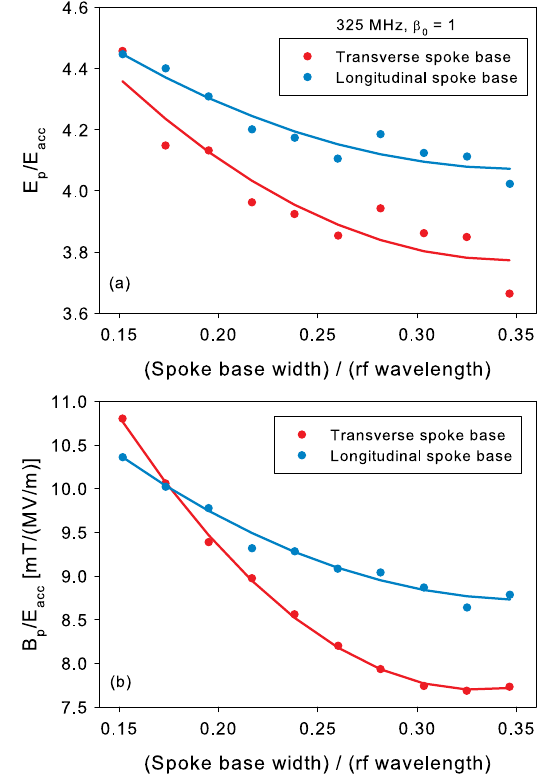
FIG. 9. (a) Dependence of RR s and (b) energy content (at 1 MV = m ) on the spoke base width.